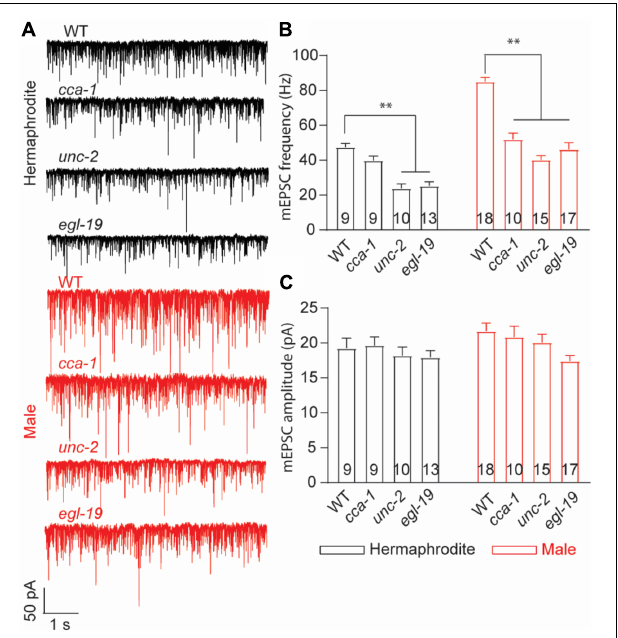
FIGURE 6 | T-type calcium channel CCA-1 plays different roles in ACh release between adult hermaphrodites and males. (A) Sample traces of mEPSC recorded from the NMJs of adult WT and calcium channel mutants. Bar graph of the frequency (B) and the amplitude (C) of mEPSC recorded from adult WT and calcium channel mutants. Sample sizes ( n numbers) are indicated in the bars of each graph. All data are represented as mean ± SEM ( ∗ p < 0.05, ∗∗ p < 0.01, two-way ANOVA with Dunnett test).